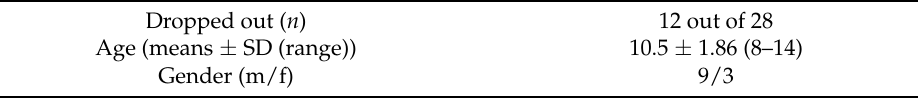
Table 2. Characteristics of dropped out